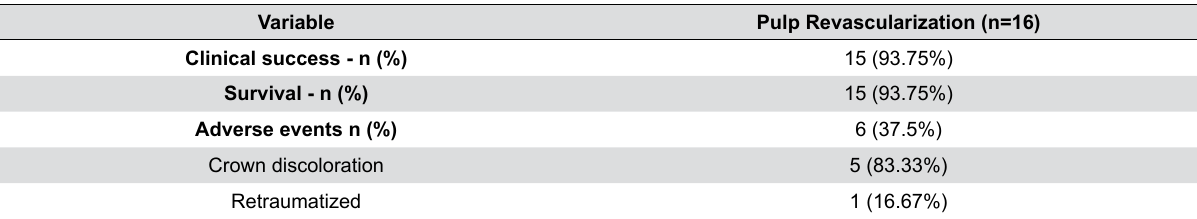
Table 2- Clinical outcomes and adverse